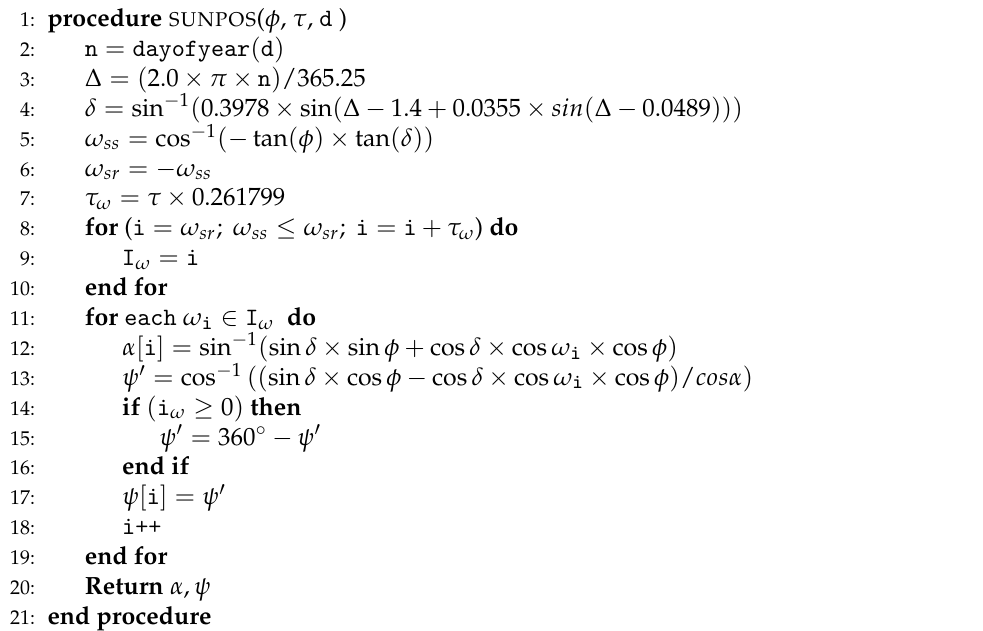
Algorithm 1 Sun Position Calculation from Sunrise to